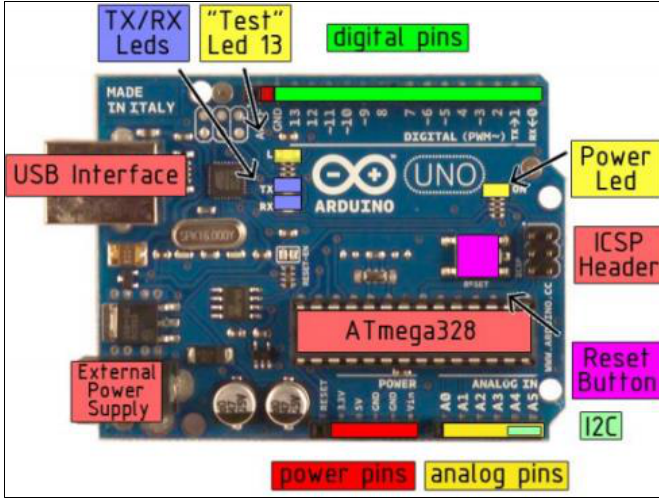
Figure 7: Arduino UNO